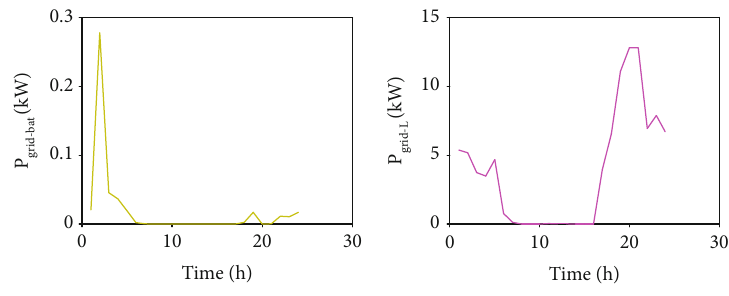
Figure 15: Import and export of grid power in strategy Table 6: Optimal cost and cost saving comparison.